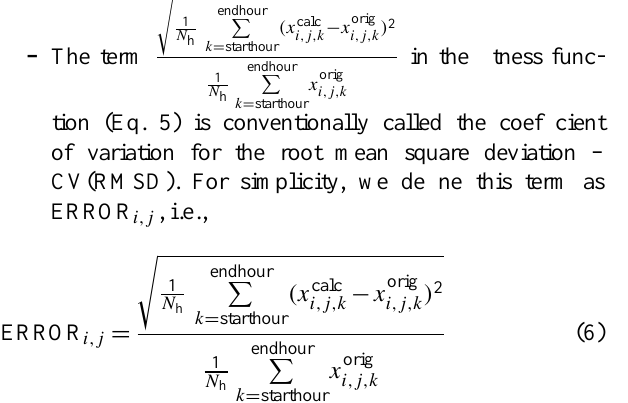
Fig. 3. Schematic representation of procedures used for a simple GAs